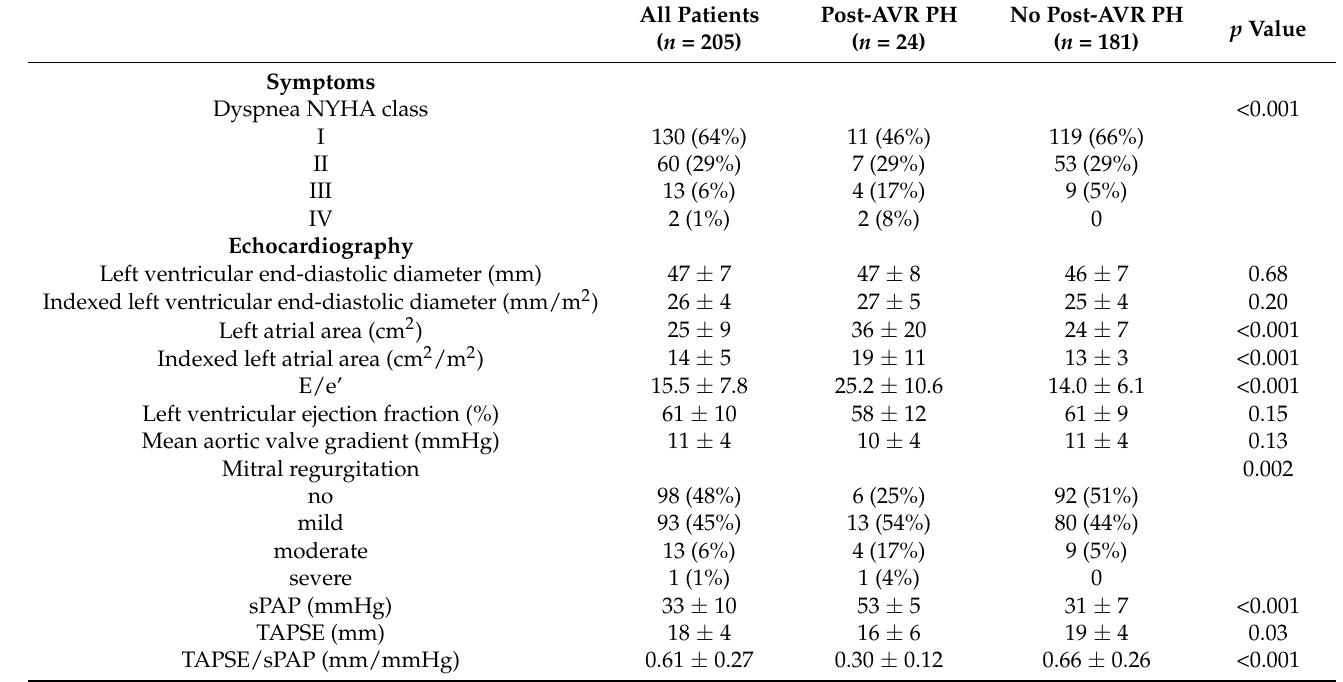
Data are given as number and percentages or mean ± standard deviation. E/e’ = ratio of peak early mitral inflow velocity to peak early mitral annular velocity; NYHA = New York _Heart Association; sPAP = systolic pulmonary artery pressure; TAPSE = tricuspid annular plane systolic